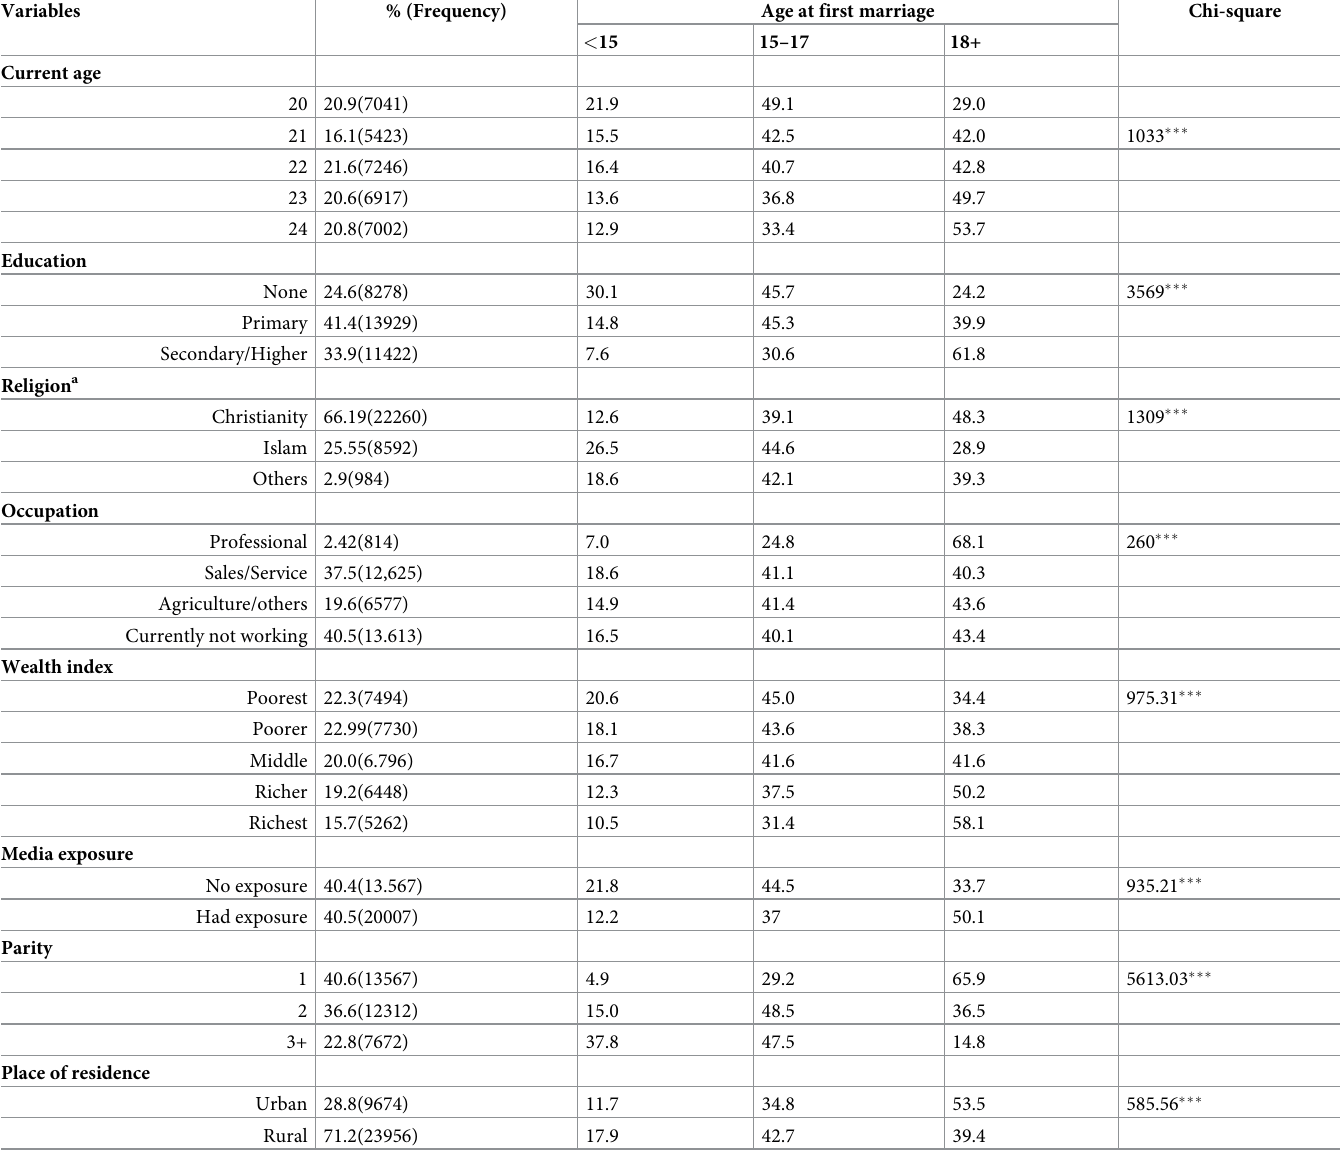
Table 3. Percentage distribution of study participants aged 20–24 by age at first marriage and according to selected background characteristics (pooled data